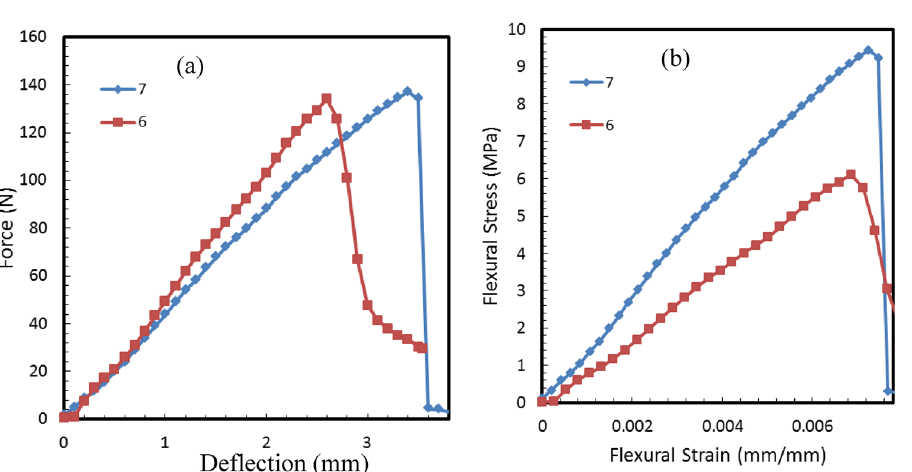
Figure 20. Bending tests for the composite (melted) samples 6 and 7, ( a ) load–deflection and ( b ) stress–strain profiles.